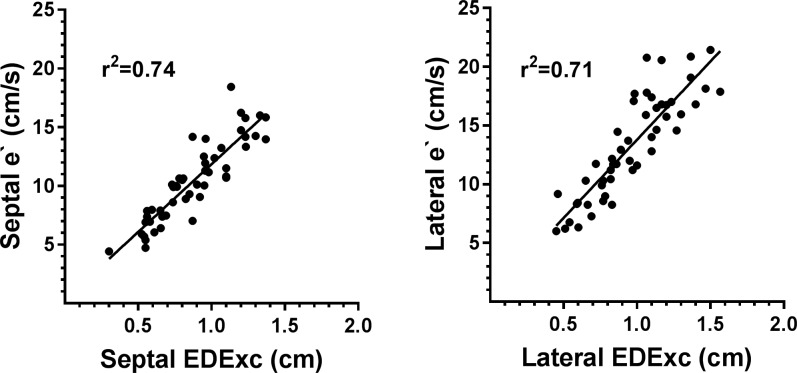
Scatter plots showing the relationships of e`with EDExc for the septal and lateral walls.